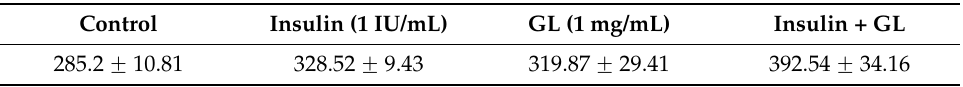
Table 3. Effect of an ethanolic extract of Gongronema latifolium on glucose uptake by isolated rat